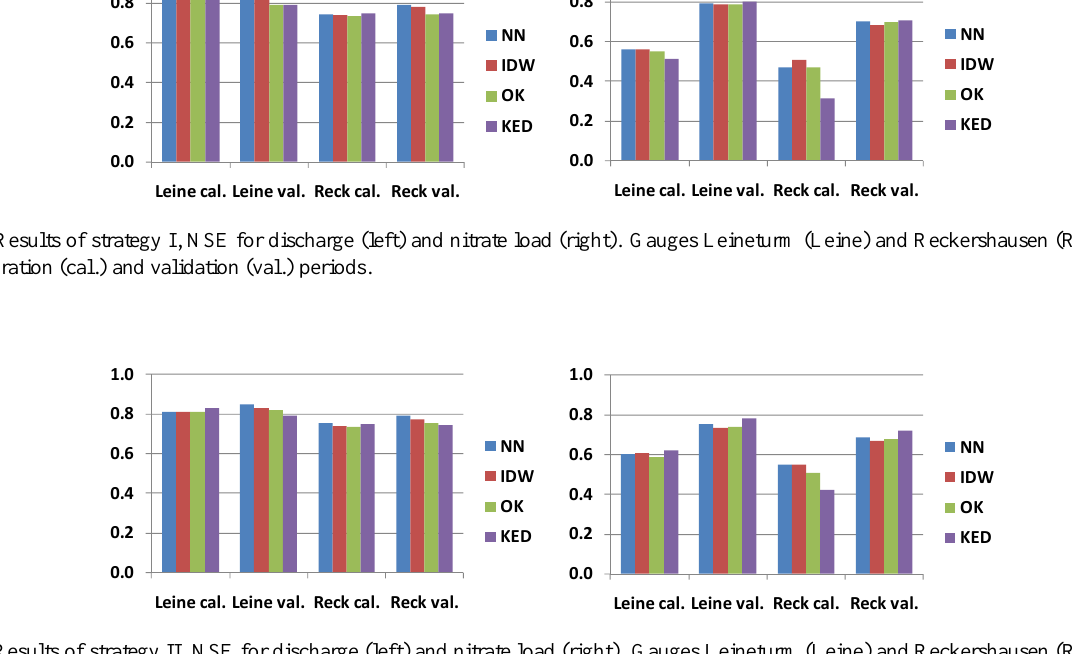
Fig. 4. Results of strategy II, NSE for discharge (left) and nitrate load (right). Gauges Leineturm (Leine) and Reckershausen (Reck) shown for calibration (cal.) and validation (val.) periods.